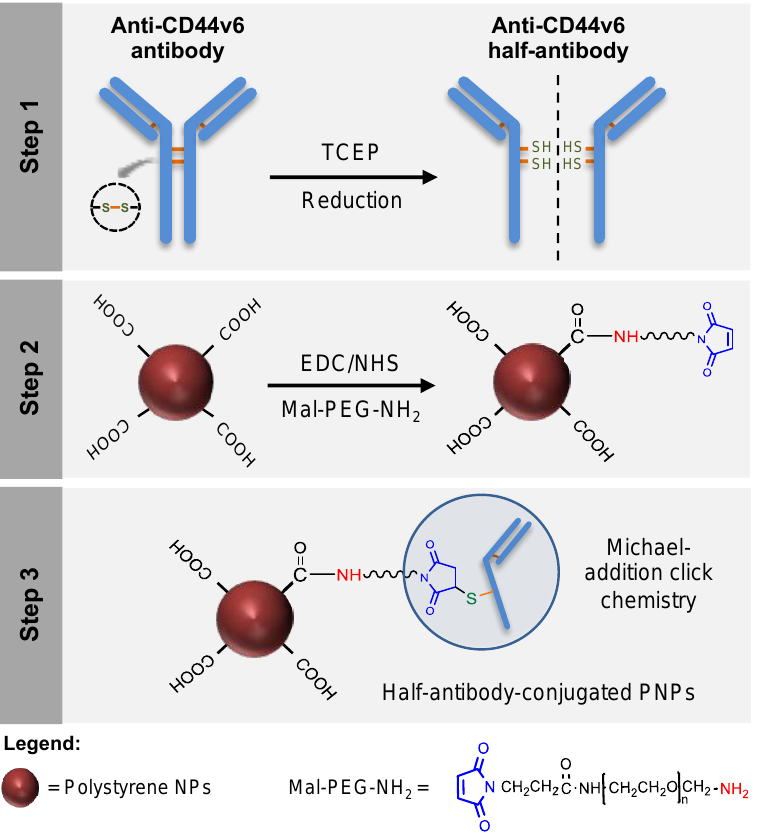
Figure 1. Design of a modular CD44v6 half-antibody conjugated nanoscale system using a bioorthogonal strategy. Schematic representation of the synthesis of CD44v6 half-antibody conjugated polystyrene nanoparticles (PNPs). Step 1 illustrates the selective reduction of CD44v6 antibody to half-antibody fragments using tris(2-carboxyethyl)phosphine (TCEP). Step 2 depicts the conjugation of carboxyl-terminated PNPs to maleimide-polyethylene glycol-amine (Mal-PEG-NH 2 ) spacer by carbodiimide chemistry. Step 3 demonstrates the site-directed conjugation of reduced half-antibody to maleimide-PEG modified PNPs by thiol-Michael addition click chemistry, leaving the antigen-binding region free to recognize the CD44v6 receptor.